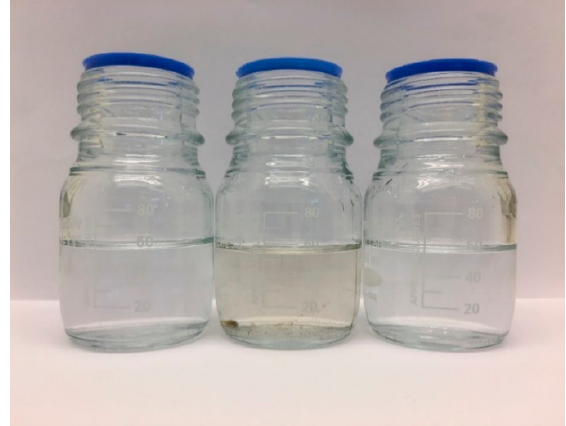
Figure 7. Samples of wastewater treatment plant effluent ( middle ), permeate of the membrane with surfactant/oxide ratio (S/O) = 0.5 ( left ), and permeate of the membrane with S/O = 2.0 ( right ).